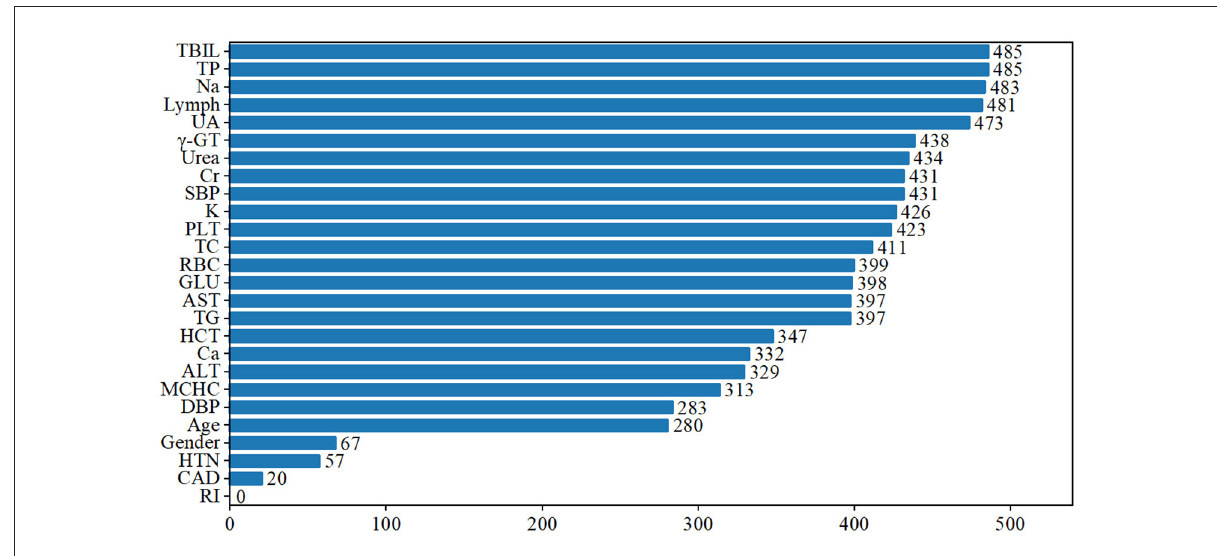
FIGURE5 Ranking of feature importance in the LightGBM